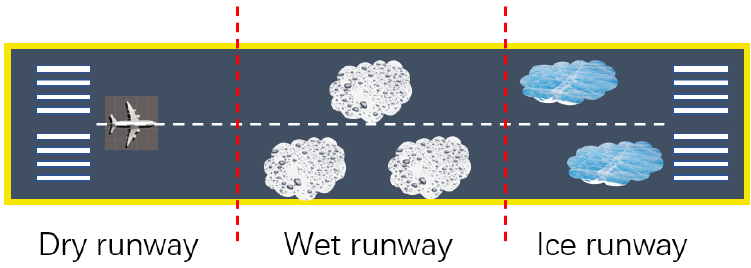
Figure 10. Schematic diagram of mixed runway layout.